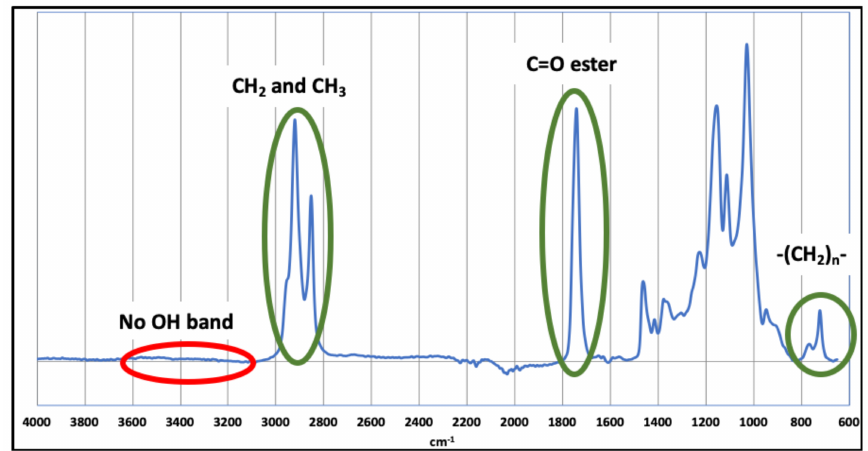
Figure 1. FT-IR spectrum of FASE.